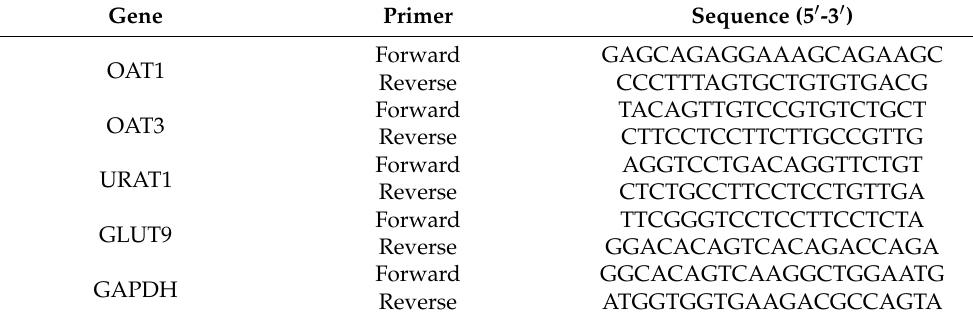
Table 1. Primer sequences for